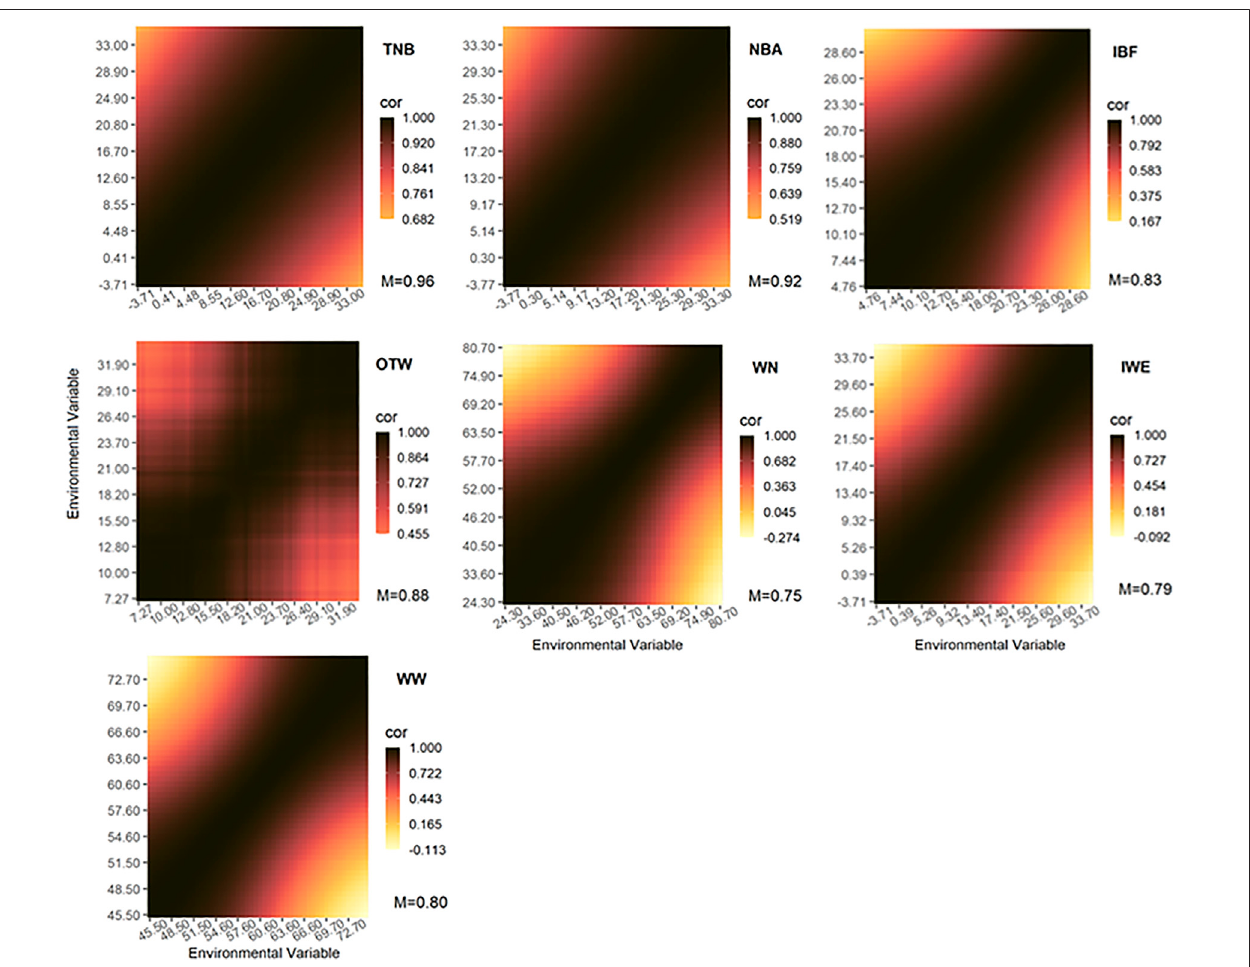
FIGURE 3 | Genetic correlations across environmental gradients using the recommended environmental variable and critical period for each studied trait. The Pearson correlation coef fi cient (cor) are represented by colors with the mean values shown below. TNB, total number of piglets born; NBA, number ofpiglets born alive; WN, number of piglets weaned considering the measurement of records until weaning date; WW, weaning weight (kg) considering measurement until weaning date; IWE, interval between wean to estrus (days); IBF, interval between farrows (days); OTW, off-test weight (kg) considering an interval of 30 days.